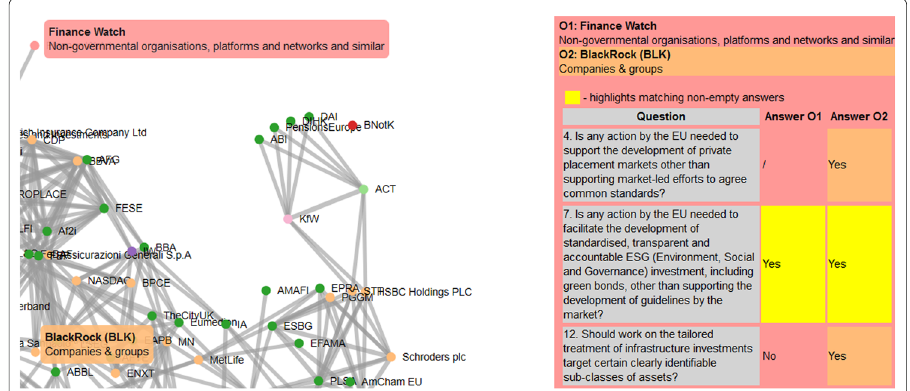
Fig. 6 Interactive exploration and comparison of the lobby organizations. On the left-hand side is a network of organizations, linked by similar responses to the same consultations. On the right-hand side is a selected questionnaire, comparing answers by two selected lobby